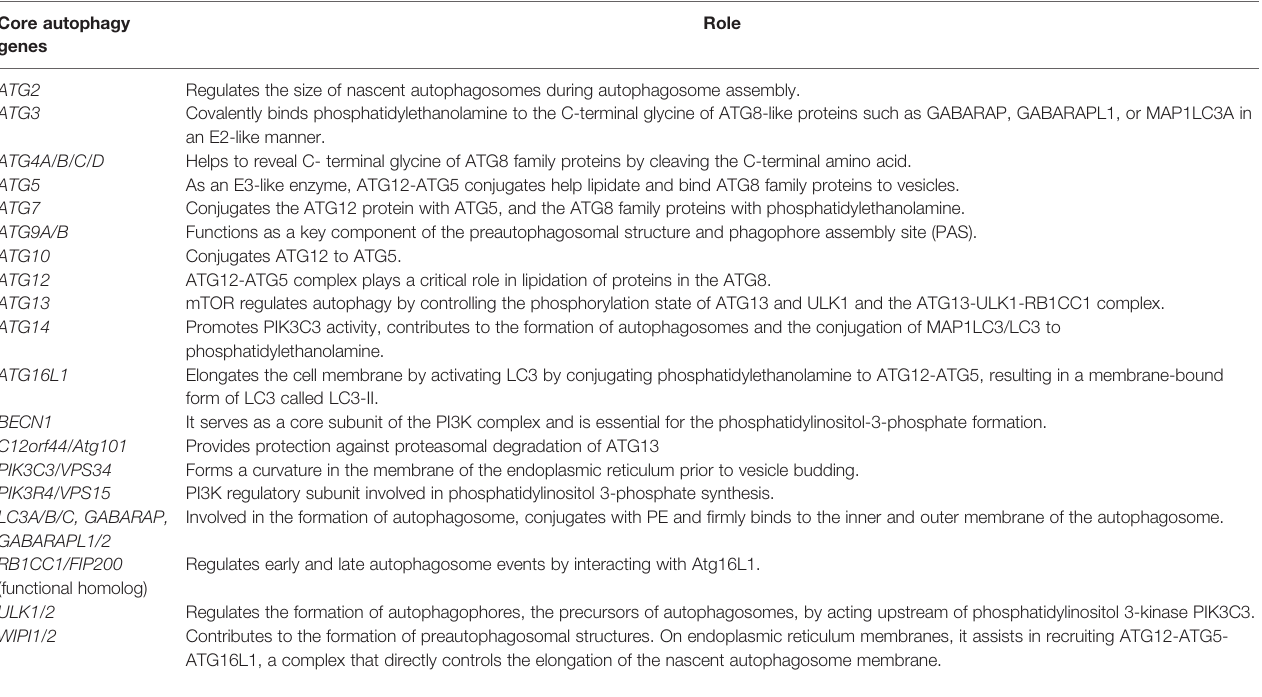
TABLE 1 | Core autophagy genes and their